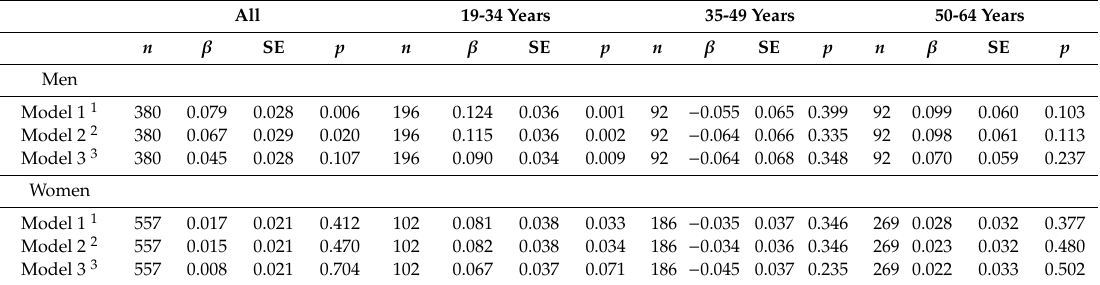
Table 3. Multiple linear regression analysis for the association between the RFS and VO 2max according to age and